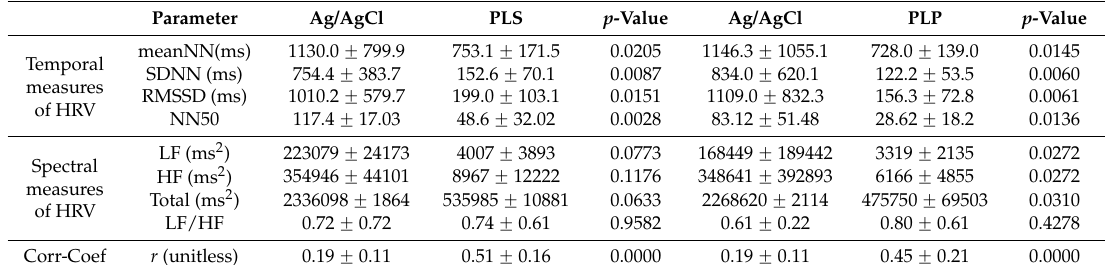
Table 4. Electrocardiogram signal quality—freshwater immersion with movement condition.